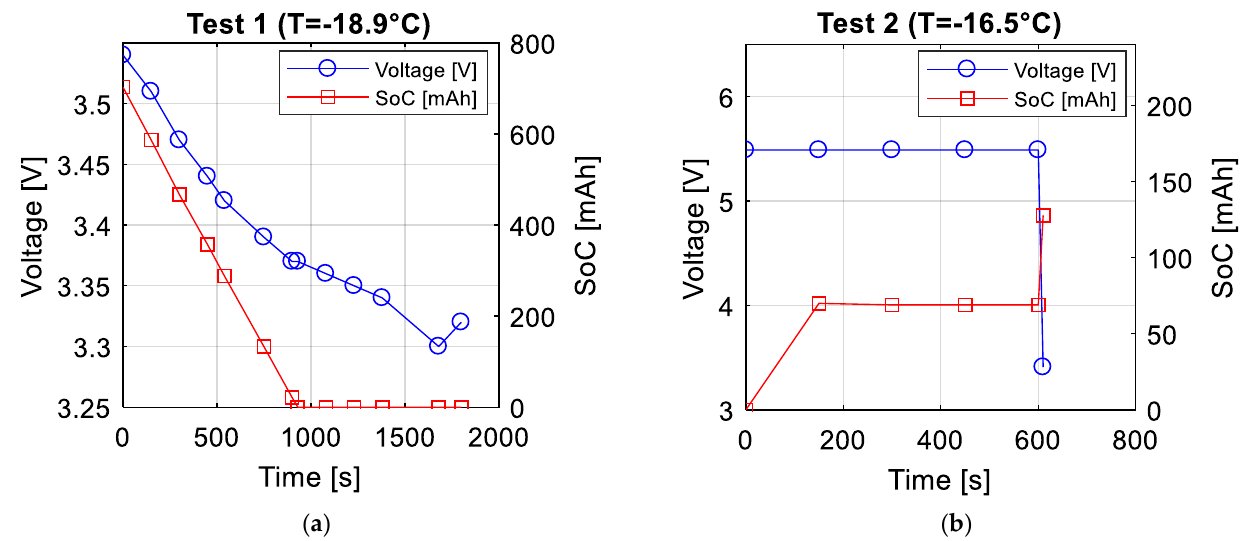
Figure 8. Temperature test: ( a ) Battery voltage and SoC (State of Charge) trends when battery is discharging (Test 1) and ( b ) battery voltage and SoC trends when battery is recharging (Test 2).